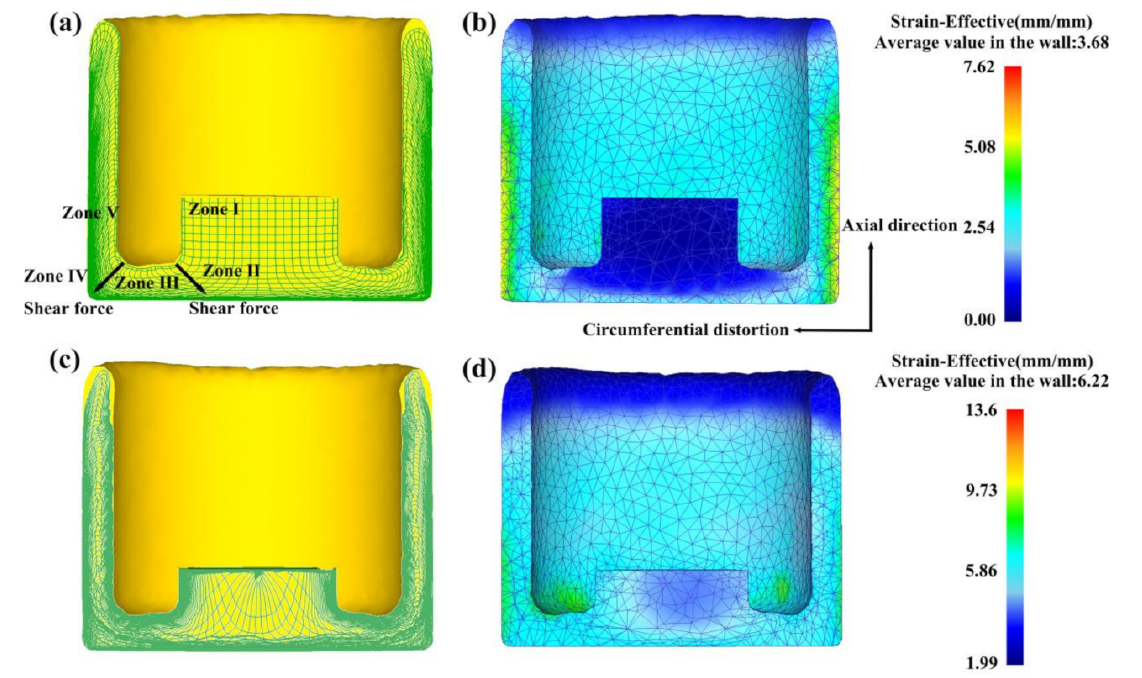
Figure 3. Mesh flow simulation of: ( a ) ACAE; and ( c ) UE + ACAE. Effective strain distribution simulation of: ( b ) ACAE; and ( d ) UE +